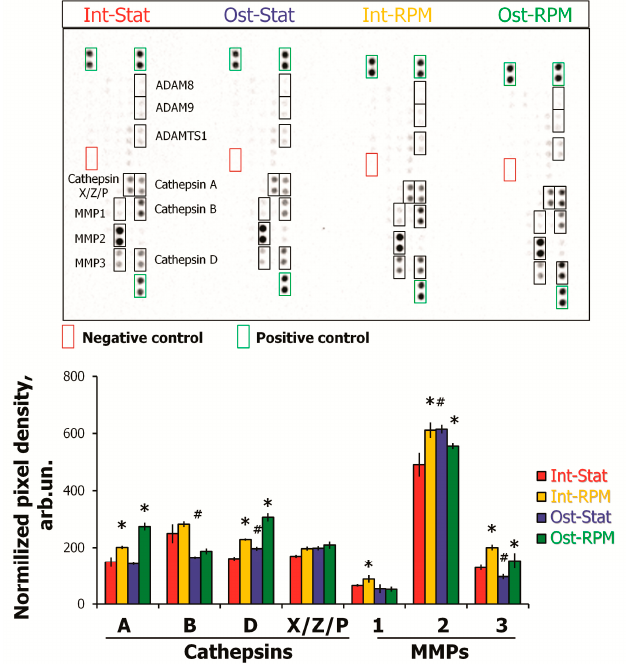
Figure 8. Evaluation of protease levels in conditioned medium of MSCs after 10 days of RPM exposure using Proteome Profiler Human Protease Array Kit. Representative image of the dot blotting of protein levels is shown. Densitometric analysis of certain analytes was performed using ImageLab software (Bio-Rad, Hercules, CA, USA). The major proteins are demonstrated. The data were normalized to positive control and are shown as mean ± SD; n ≥ 4, * p < 0.05 (RPM vs.